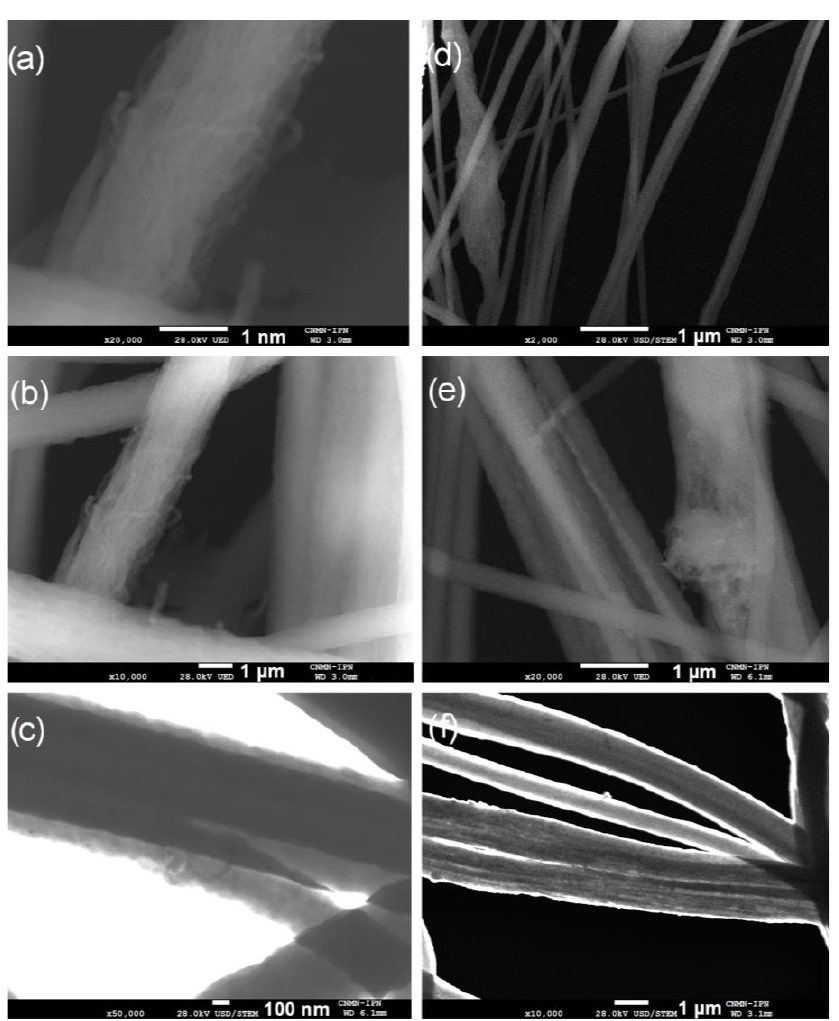
Figure 7. SEM micrographs of P(S:AN) 20:80 wt.%:wt.% yarns with different CNTs contents and amplifications: 0.5 wt.% ( a ) ×20,000 ( b ) ×10,000 ( c ) ×50,000 and 1.0 wt.% ( d ) ×2000 ( e ) ×20,000 ( f ) ×10,000.